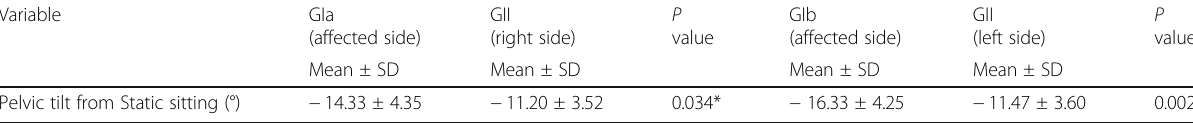
Table 1 Mean values of sagittal pelvic tilt angles in degrees (°) of three groups during static sitting by Palpation meter inclinometer Variable